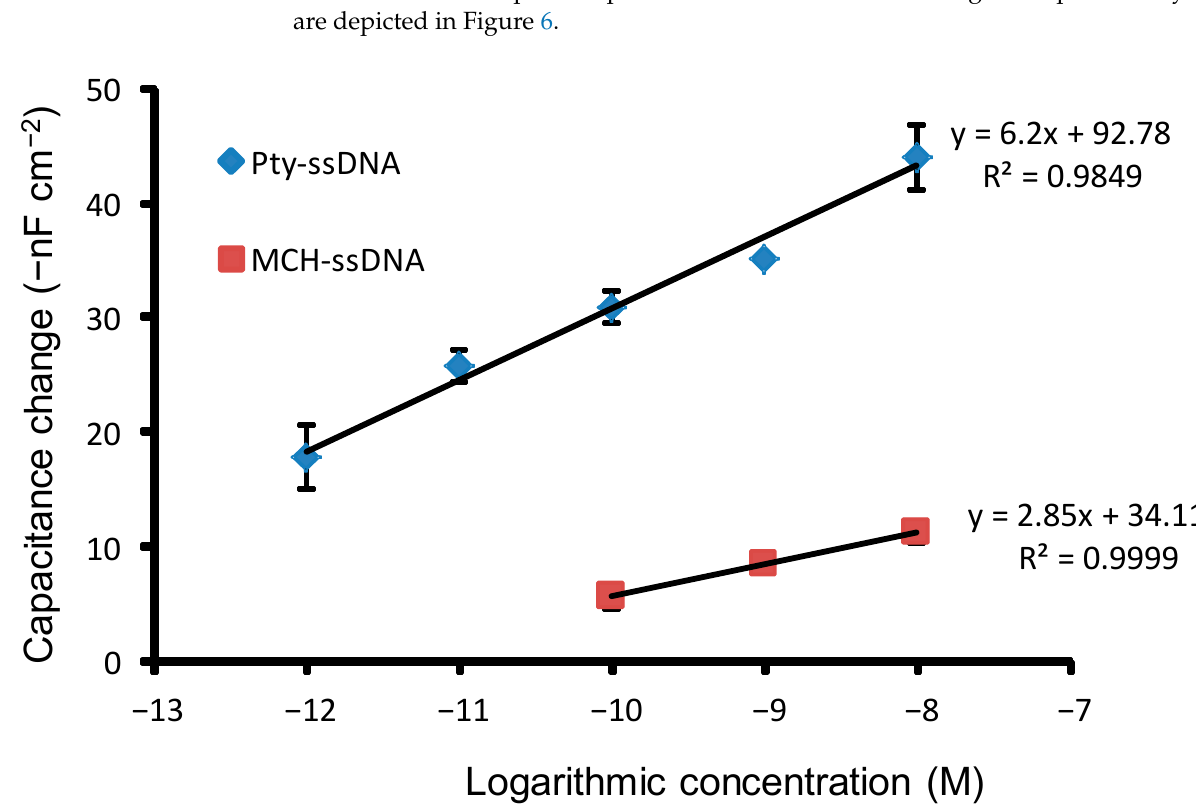
Figure 6. Calibration curves showing linearity range for target ssDNA hybridized with capture probe on the different sensor chips modified with Pty-ssDNA and MCH-ssDNA.